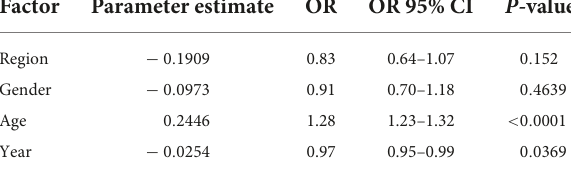
TABLE 3 The risk factors in mental disorders deaths for Chinese residents from 2002 to